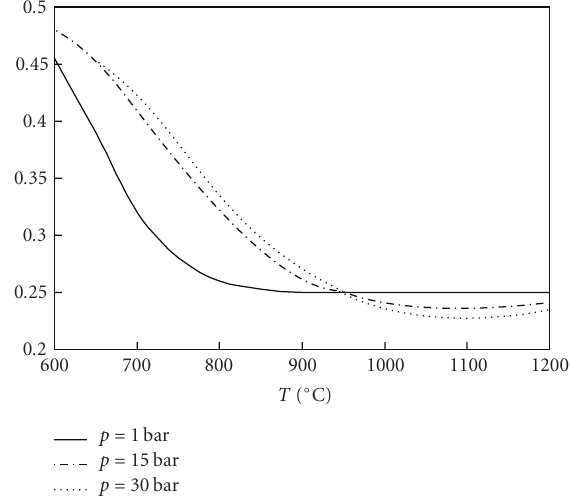
Figure 9: The oxygen added ratio, σ , needed to avoid carbon formation when CH 4 is used as fuel